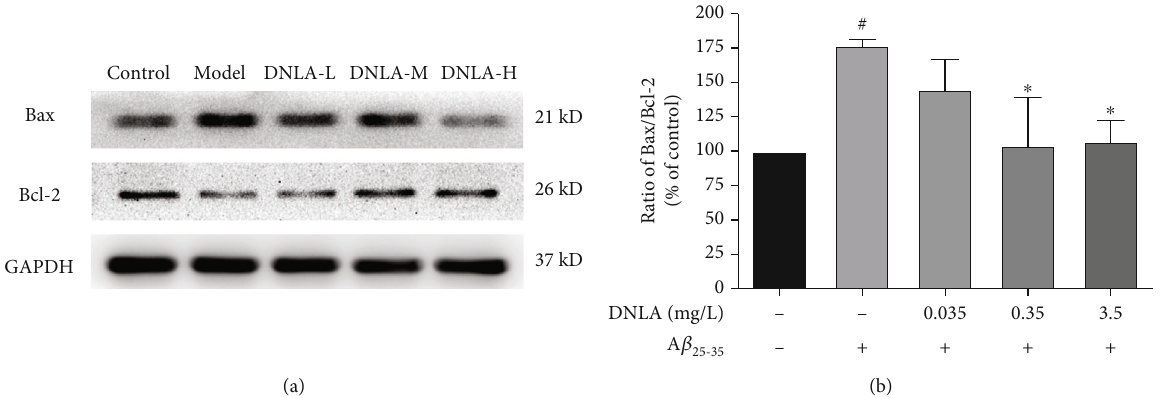
in cells. (a) Respective photomicrographs of A β 25-35